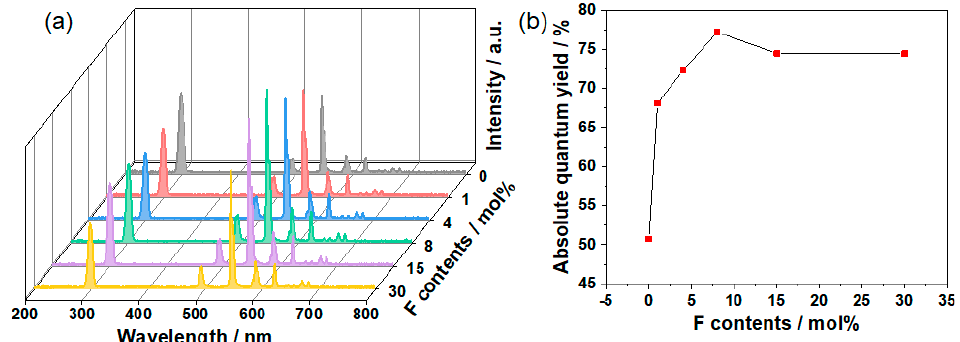
Figure 5. ( a ) Excitation spectra ( λ em = 545 nm, 200–400 nm) and emission spectra ( λ ex = 298 nm, 400–800 nm) of the GOS:Tb, x F scintillators. ( b ) Absolute QY of the GOS:Tb, x F scintillators.